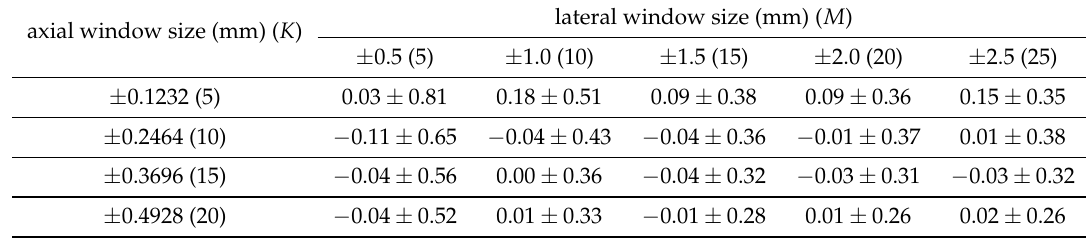
Table 5. Bias errors e bias and standard deviations σ of lateral and axial displacements at nine red points in Figure 4a estimated by the proposed 2D motion estimator with frame averaging. Beamformed echo signals were obtained with Hanning apodization. Actual lateral and axial velocities were 2 mm/s and –1 mm/s, respectively.